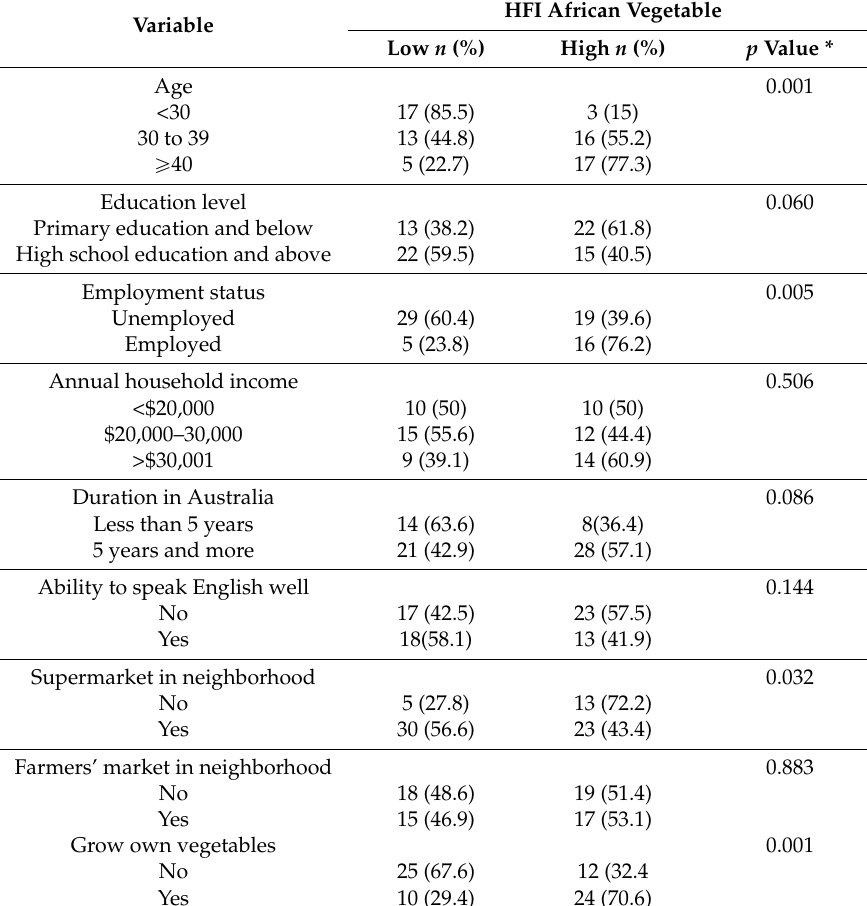
Table 3. Associations between socio-demographic and food environment characteristics with home availability of traditional vegetables.